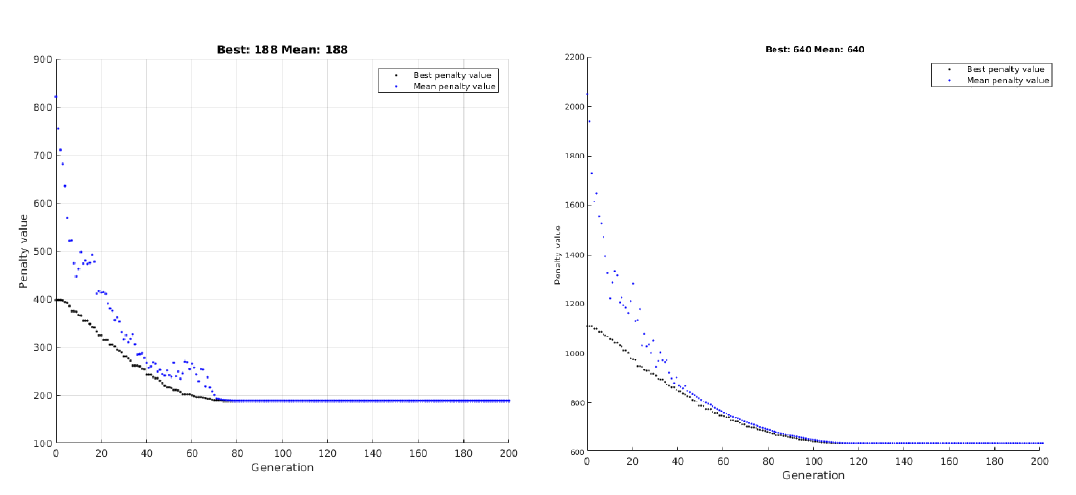
Figure 7. Genetic Algorithm performance solving the real example cities